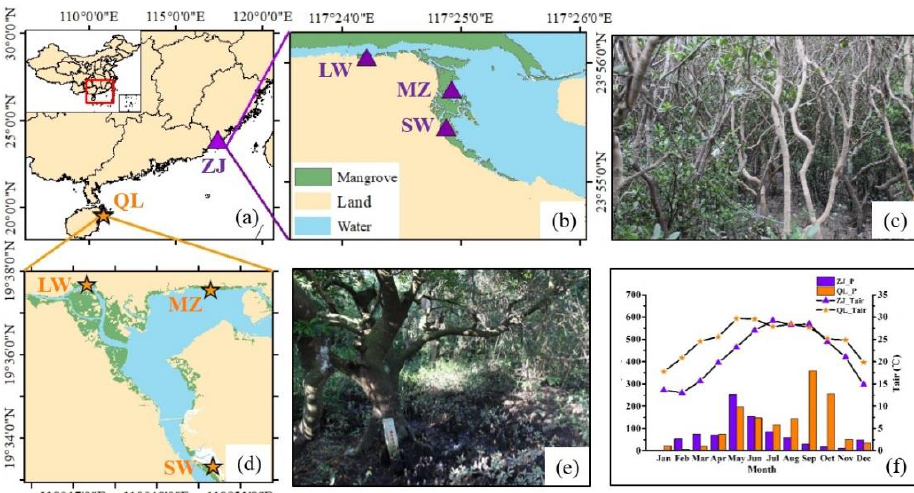
Figure 1. Map of sampling location and climatic conditions. ( a ) Geographical location of Zhangjiang Estuary (ZJ) and Qinglan Harbour (QL) mangrove wetlands. ( b , c ) Sampling sites and a typical scene from ZJ mangrove forest. ( d , e ) Sampling sites and a typical scene from QL mangrove forest. ( f ) Monthly precipitation (P, mm) and monthly air temperature (T, °C) from ZJ and QL mangrove wetlands. LW: landward zone, MZ: middle zone, and SW: seaward zone.